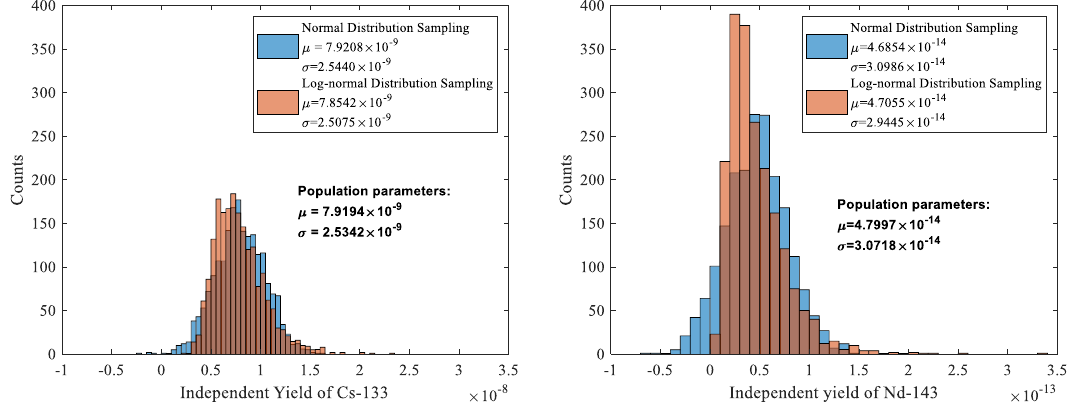
Figure 4. Histogram of 2,000 independent yield samples of Cs-134 (Left) and Nd-143 (Right). Dark brown parts are the overlaps between these two bar